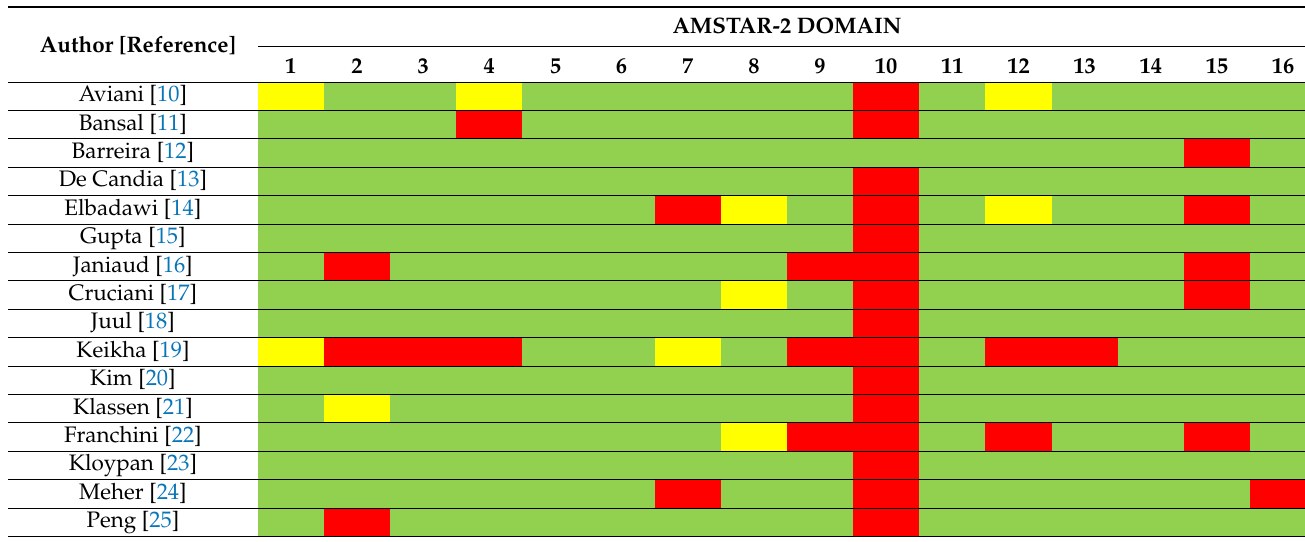
Table 2. The AMSTAR-2